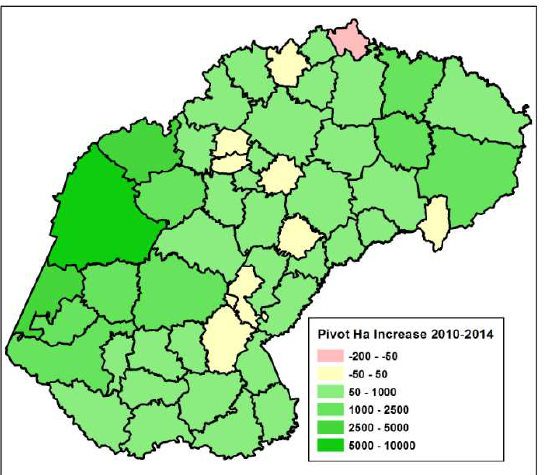
Figure 31. Increase in area Ha under pivot irrigation between 2010 and 2014 per district in the Freestate